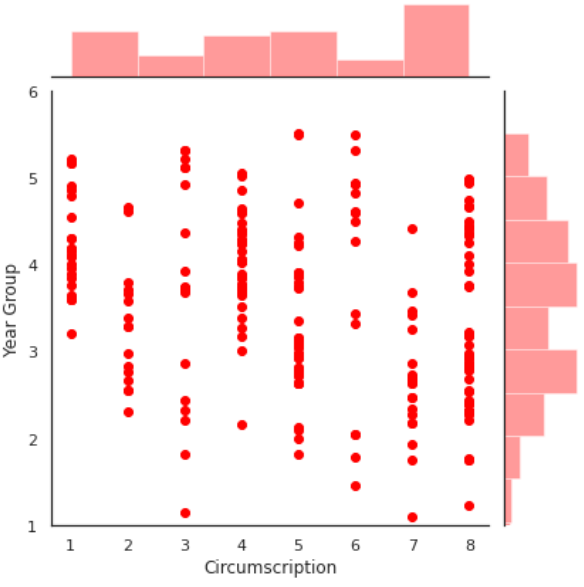
Figure 16. Jointplot of predicted future maintenance interventions grouped by circumscription.